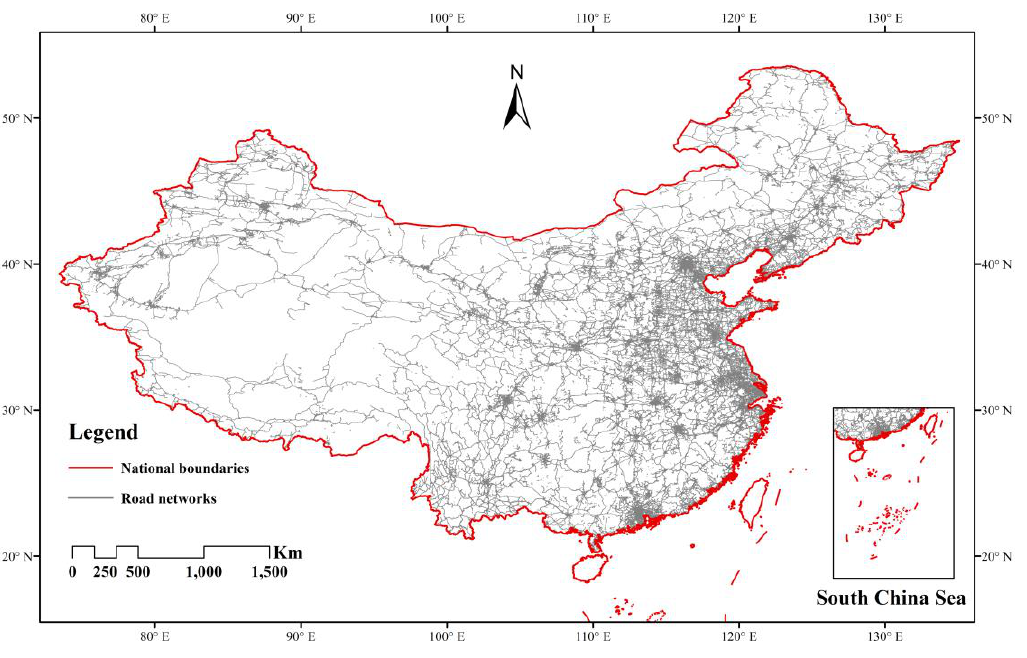
Figure 2. 2013 OpenStreetMap (OSM) road network.